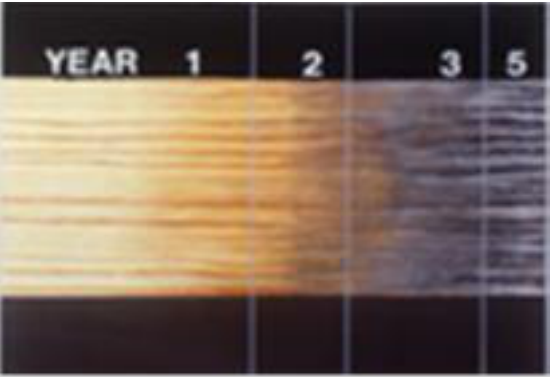
Figure 6. Color change in the wood surface exposed to UV energy.